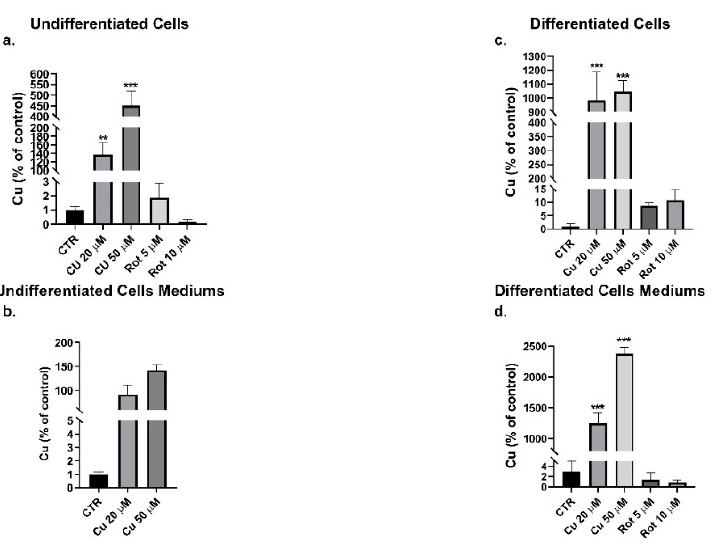
Figure 5. Atomic absorption spectrometry. Undifferentiated (left) and differentiated (right) cells treated with the indicated concentrations of copper for 48 h or rotenone for 24 h were analyzed by atomic absorption spectrometry to determine the intracellular copper content ( a – c ) and the residual content of the medium ( b – d ) respectively. Histogram bars represent means ± SD of three independent experiments. Values of intracellular copper were normalized on total protein and compared with untreated cells (CTR) by one-way ANOVA following Tukey test ** p < 0.0021 *** p < 0.0002.